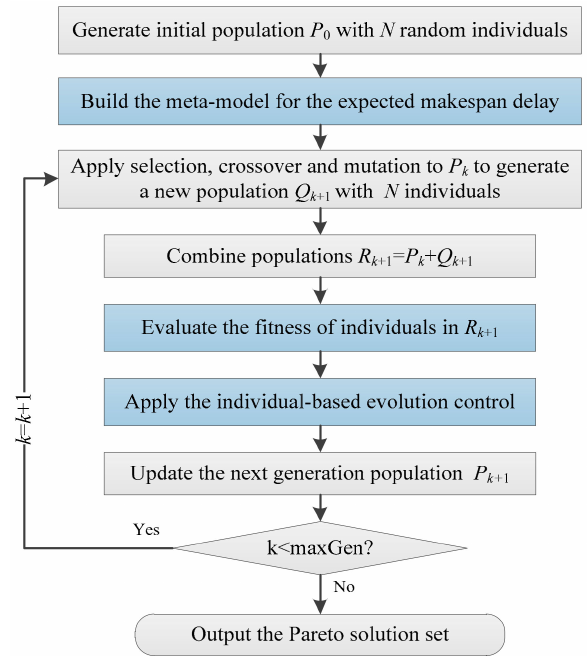
Figure 2. The flow chart of the meta-model-based multi-objective evolutionary algorithm